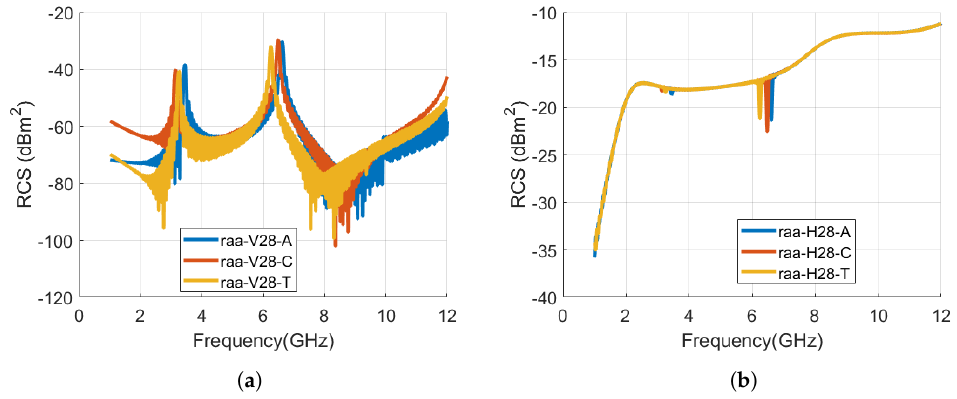
Figure 12. Comparison of RCS results of alphabet P tag with various font types (Arial, Calibri, and Times New Roman) with the font size of 28: ( a ) Vertical polarization; ( b ) Horizontal polarization. Table 3. Signature resonance frequencies for letter P tag with various font types (Arial, Calibri, and Times New Roman) with the font size of 28.